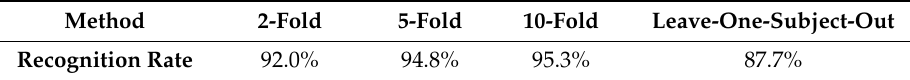
Table 3. Recognition rates for 3D gesture recognition by validation methods.